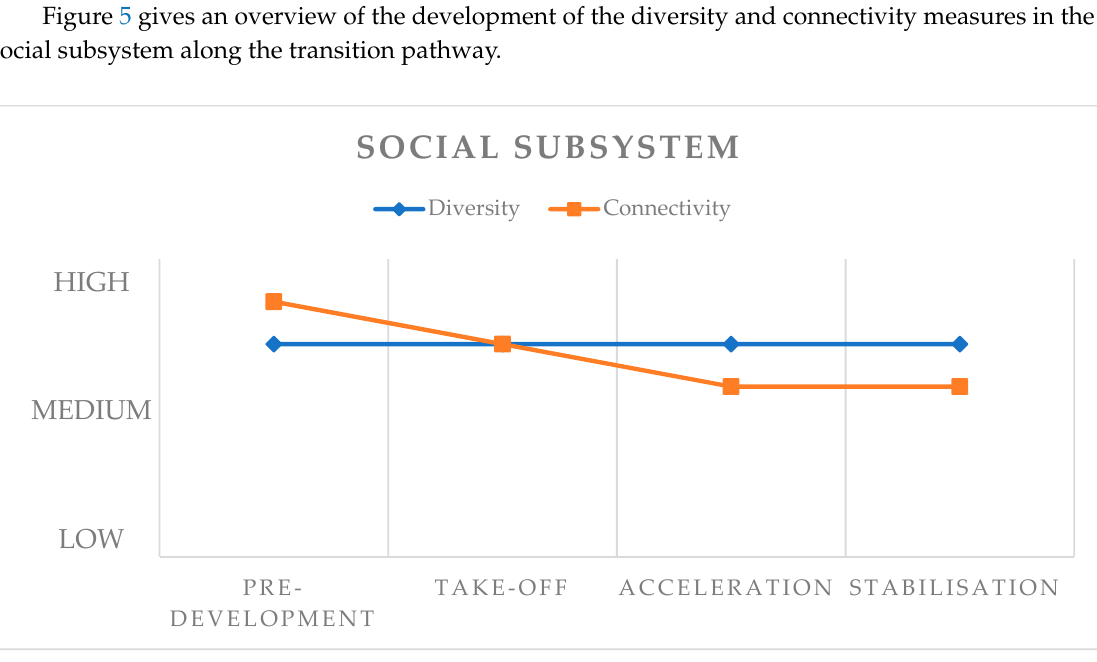
Figure 6. Development of diversity and connectivity measures in the technical subsystem.